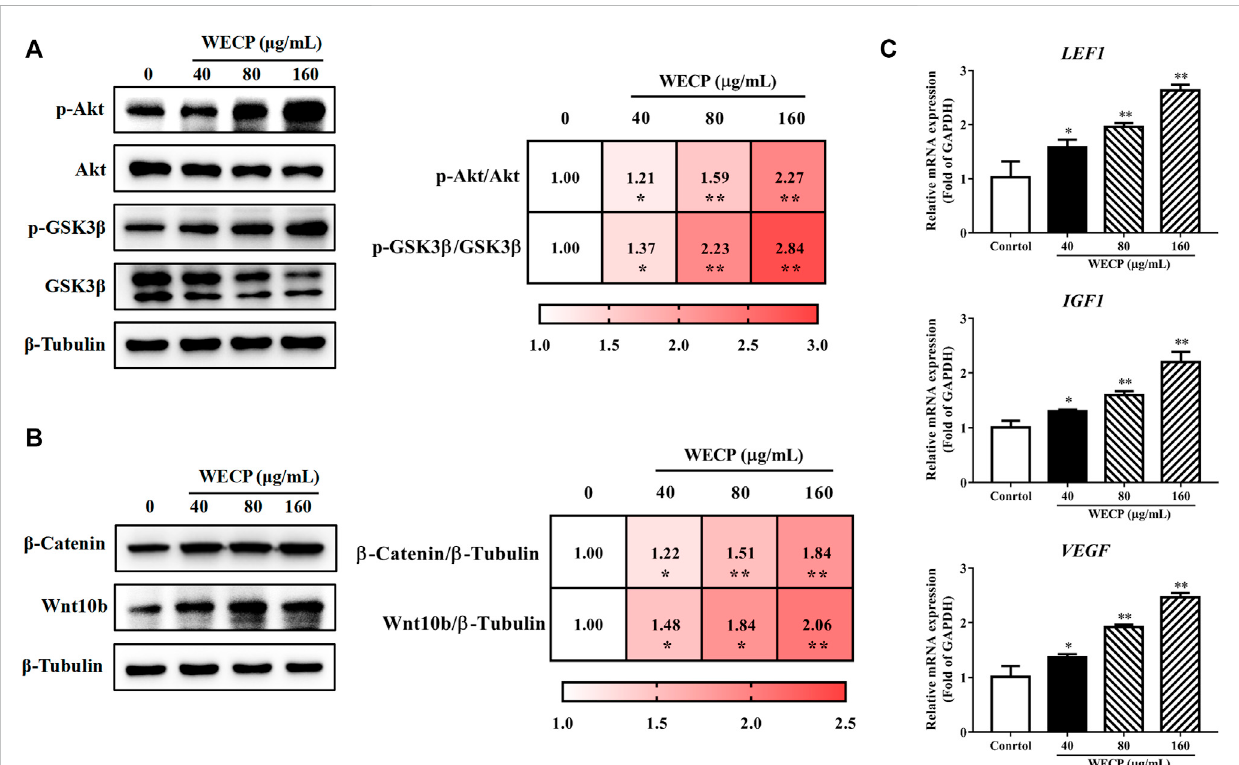
WECP activated Akt/GSK3 β / β -Catenin signaling pathway in DPCs. DPCs were incubated with WECP (40, 80 and 160 μ g/mL) in culture medium for 24 h. (A) Akt and GSK3 β phosphorylation levels were detected in DPCs after WECP treatment. (B) Effects of WECP treatment on β -Catenin and Wnt10b proteinexpressionlevels inDPCs. (C) Transcriptional expressionofLEF1, IGF1,and VEGFinDPCsdetected usingRT-PCR. Data arepresented asmeans± SD of three independent replicates. * p < 0.05, ** p < 0.01 vs. control